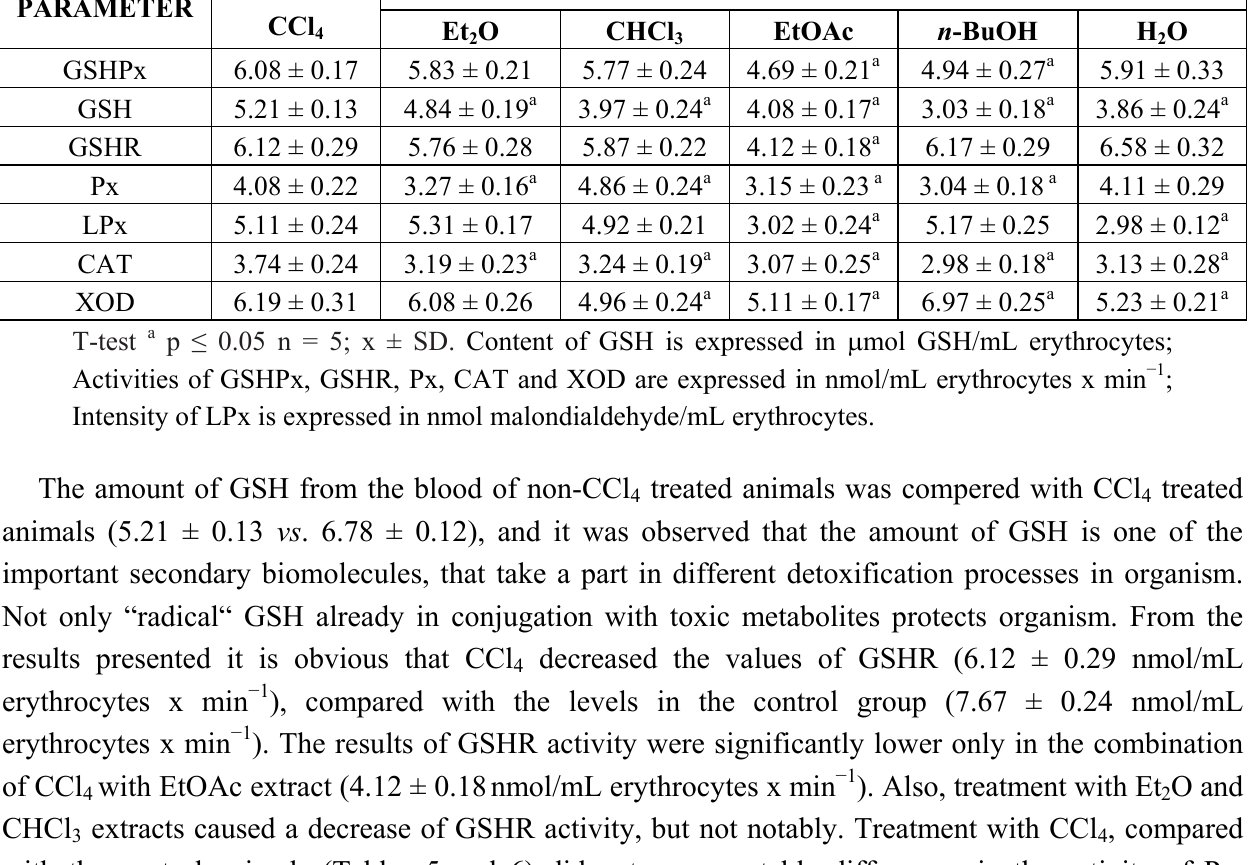
on the biochemical 4